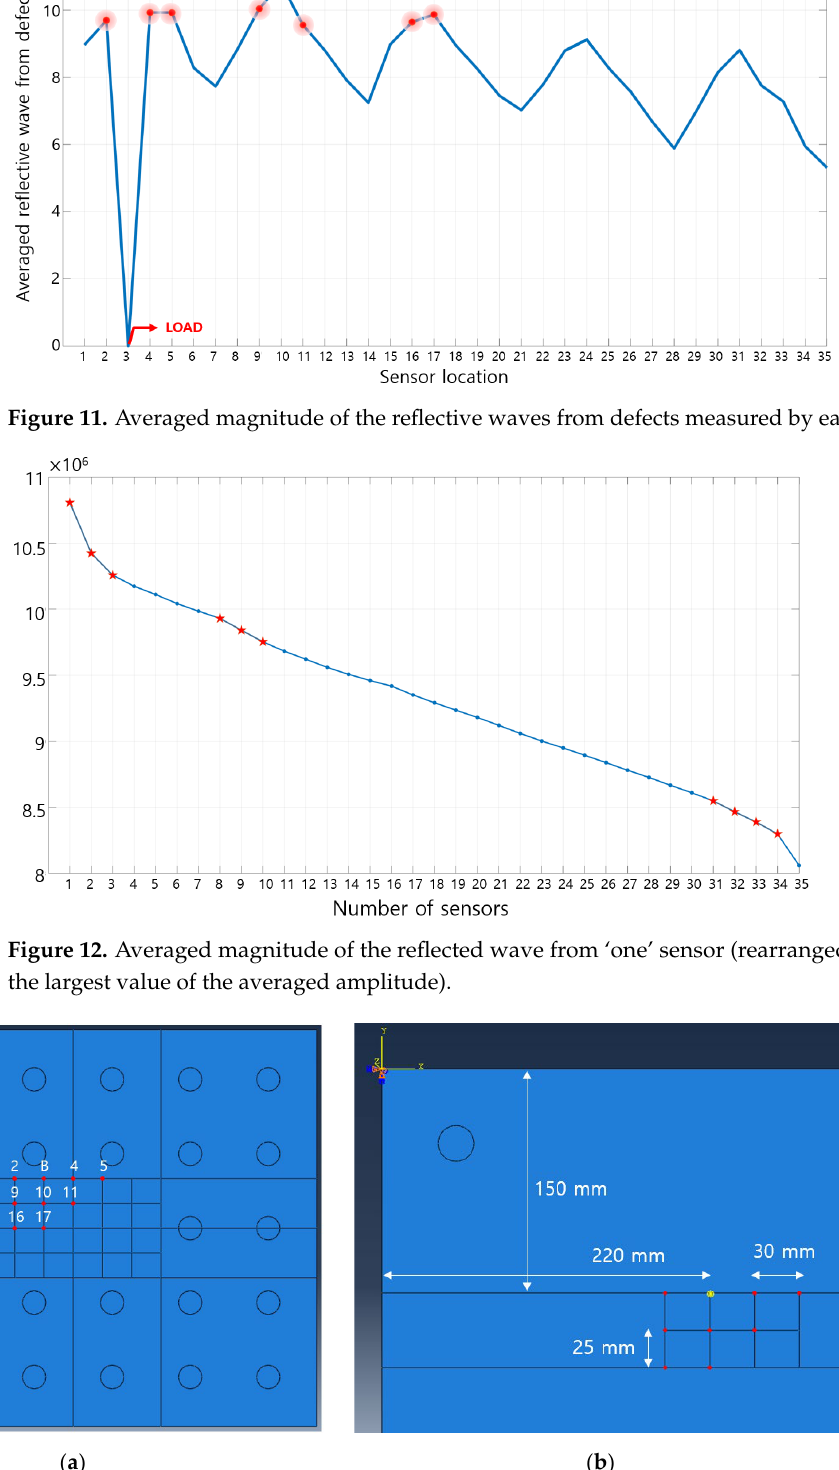
Figure 13. ( a ) Optimal transducer array configuration; ( b ) detailed dimensions of transducer array on aluminum panel.